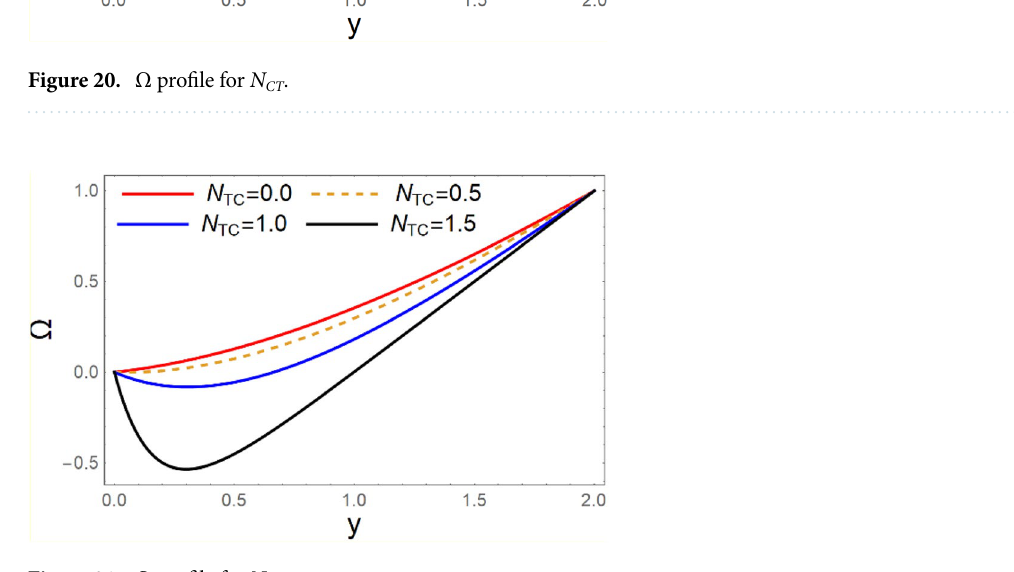
Figure 21. Ω profile for N TC